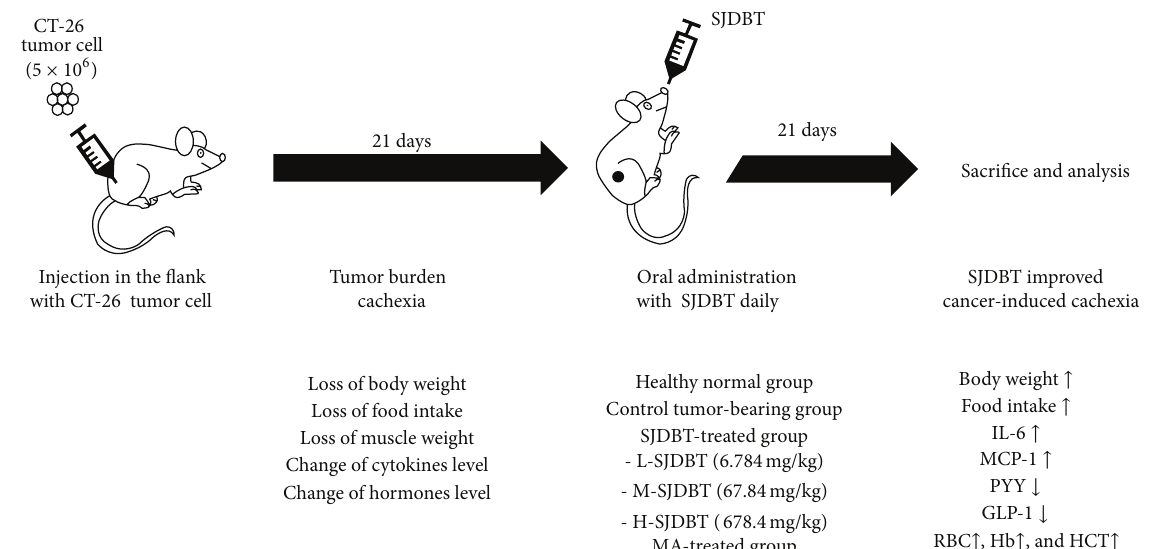
Figure 6: Schematic illustration. To set up the tumor burden cachexia mice model, mice were injected s.c. with CT-26 tumor cells. 21 days after tumor cell injection, three doses of SJDBT (L-SJDBT, M-SJDBT, and H-SJDBT) and MA were p.o. added daily. After treatment with indications for 21 days, mice were sacrificed and blood samples were analyzed for blood analysis and cytokines and hormones level in serum. SJDBT improved cancer cachexia in mice and inhibited the production of IL-6, MCP-1, PYY, and GLP-1. Therefore, we conclude that SJDBT improves cancer-induced cachexia including weight loss, anorexia, muscle wasting, anemia, and dysregulation of cytokines and hormones. levels of ghrelin and leptin were not altered by